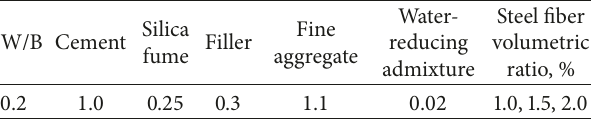
Figure 5: Details about the three-point bending test for UHPFRC [18]. Table 1: Mix proportion of UHPFRC by weight ratio